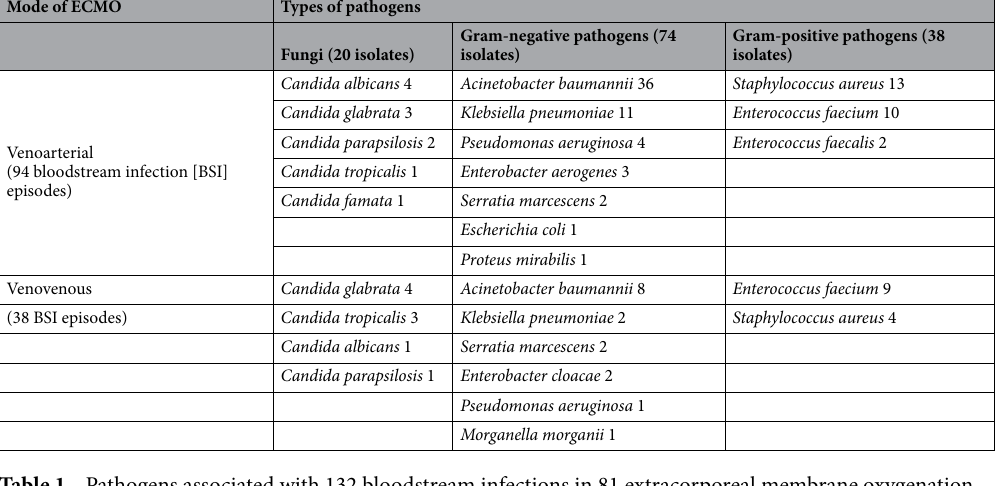
Table 1. Pathogens associated with 132 bloodstream infections in 81 extracorporeal membrane oxygenation (ECMO)